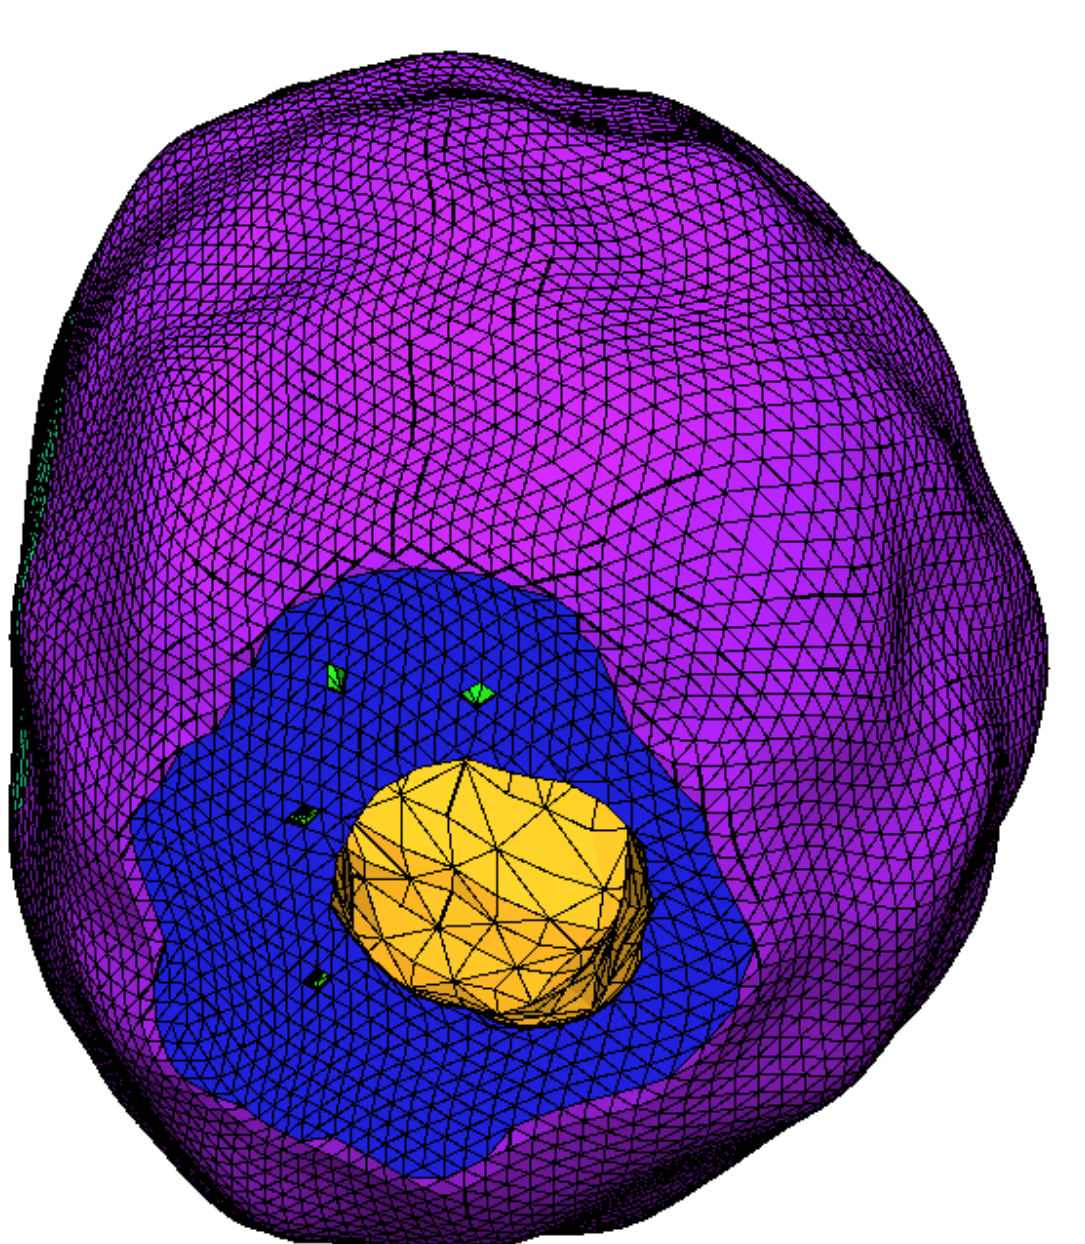
Figure 6. The two dimensional surface mesh of the real geometric model of the bouton. Microtubule— green , artificial cut— blue , mitochondrion— gold , membrane— purple